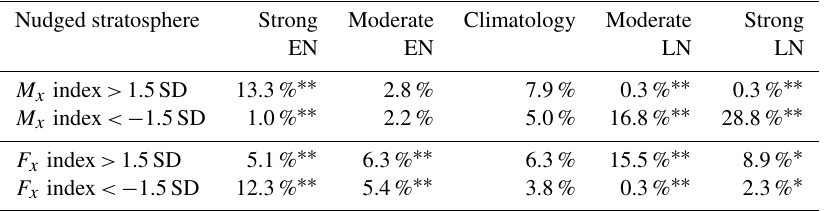
Table 1. Frequency of extreme strong and weak eastward transient ( M x index) and quasi-stationary ( F x index) monthly WAF events. Asterisks ( ∗ ) and double asterisks ( ∗∗ ) indicate that the mean value of the index distribution is statistically different from the climatological simulation at the 90% and 95% confidence level, respectively. Nudged stratosphere Strong Moderate Climatology Moderate Strong EN EN LN LN M x index > 1.5SD 13.3% ∗∗ 2.8% 7.9% 0.3%